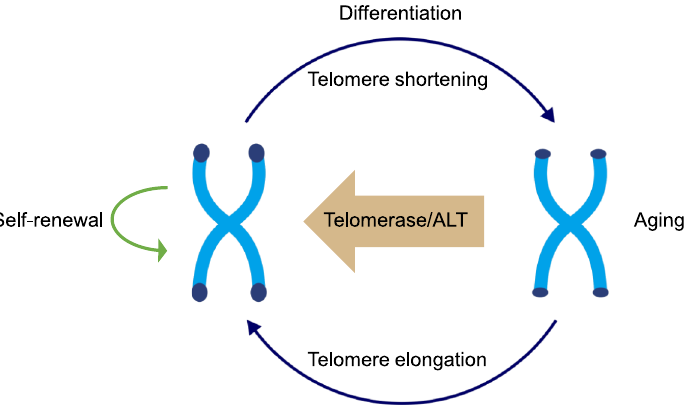
Figure 1. Telomere length and pluripotency. Due to the end replication problem, telomere shorten- ing occurs in stem cell differentiation and aging. Through telomerase and the ALT mechanism, telomeres are elongated